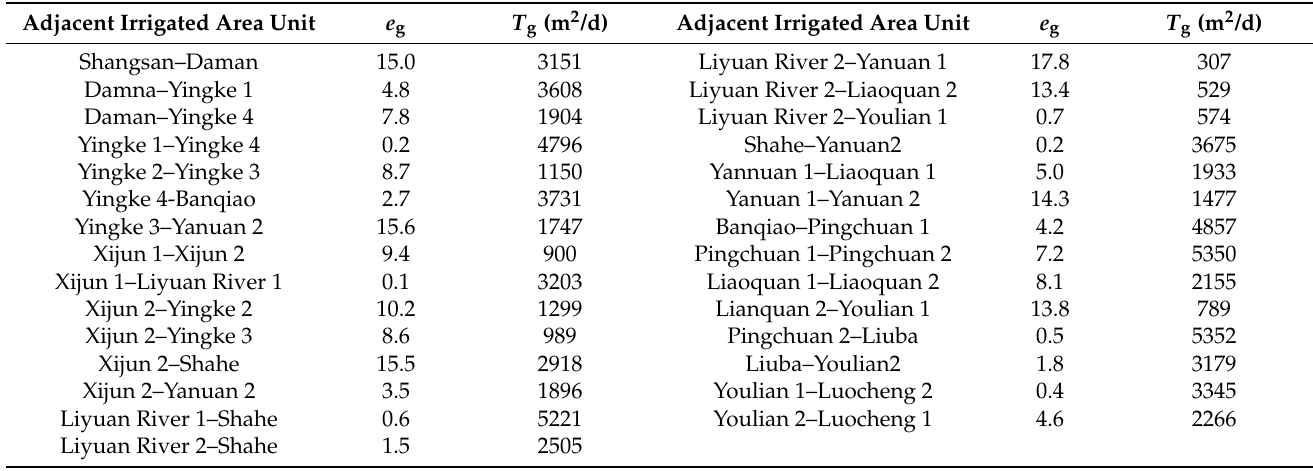
Table 5. The optimal value of the width-to-length ratio of the diving flow and the water conductivity coefficient of the adjacent irrigated area unit.